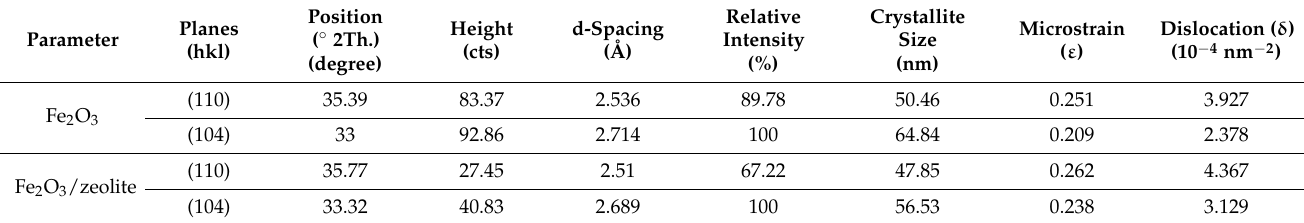
Table 2. Values of the crystallographic parameters of Fe 2 O 3 and Fe 2 O 3 /zeolite nanohybrid.